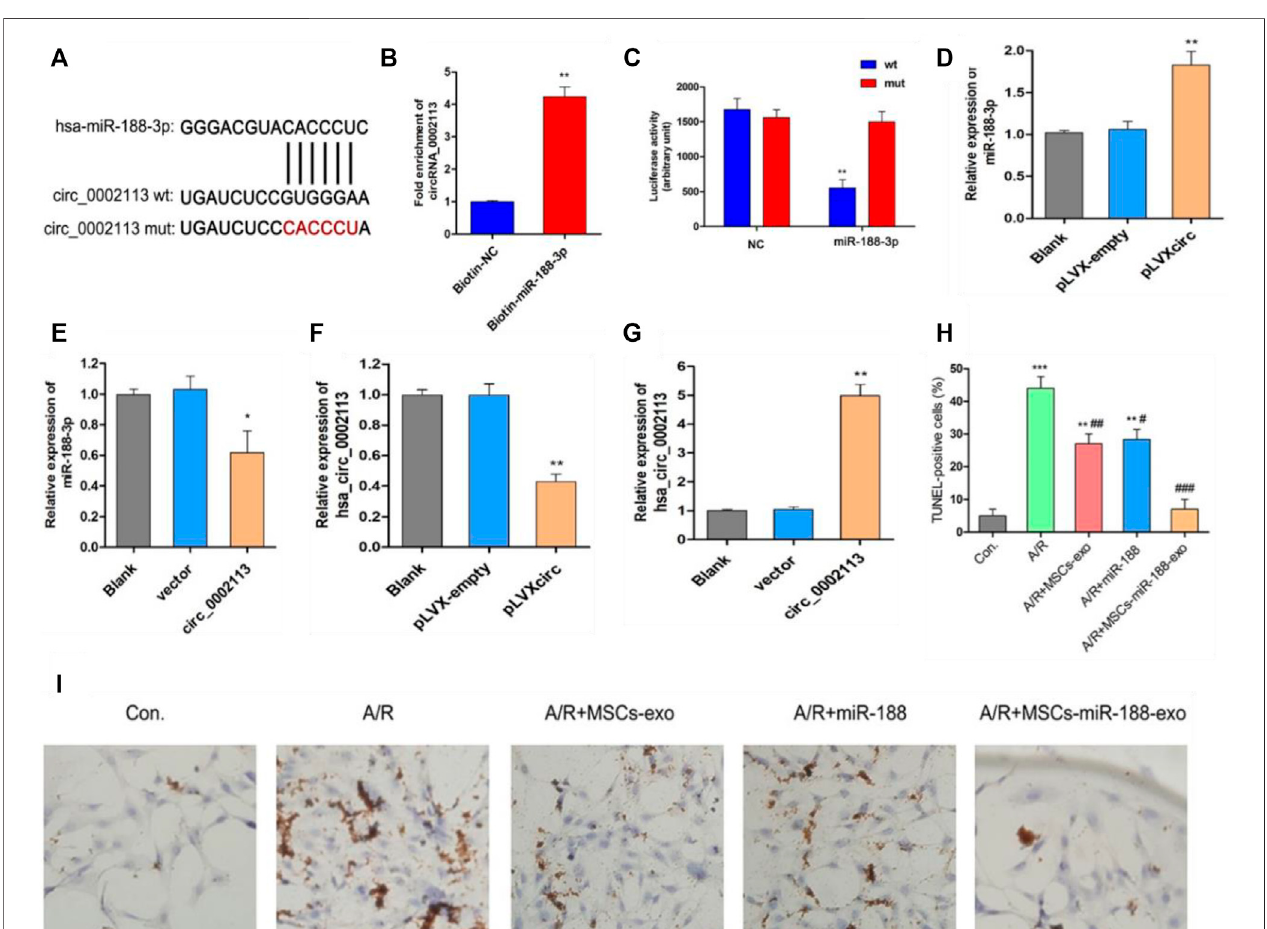
FIGURE 3 | Exosomes derived from miR-188-3p treated MSCs decreased apoptosis in A/R H9C2 cells. (A) The potential interaction sequence between circRNA_0002113 and miR-188-3p as identi fi ed by the CircInteractome program. (B) The RNA pull-down assay and (C) dual-luciferase reporter assay were used to determine the interaction of circRNA_0002113 with miR-188-3p in H9C2 cells. The expression levels of miR-188-3p were determined following (D) down-regulation or (E) up-regulation of circRNA_0002113. The expression levels of circRNA_0002113 were testi fi ed following (F) down-regulation or (G) up-regulation of circRNA_0002113. (H,I) TUNEL staining and quanti fi cation of TUNEL positive cells after 1 h of anoxia and 8 h of reoxygenation following treatment with miR-188-3p or exosomes isolated from miR-188-3p treated MSCs, Scale bar: 20 μ m * p < 0.05, ** p < 0.01, *** p < 0.001, compared with the control. # p < 0.05, ## p < 0.01, ### p < 0.001, compared with the A/R